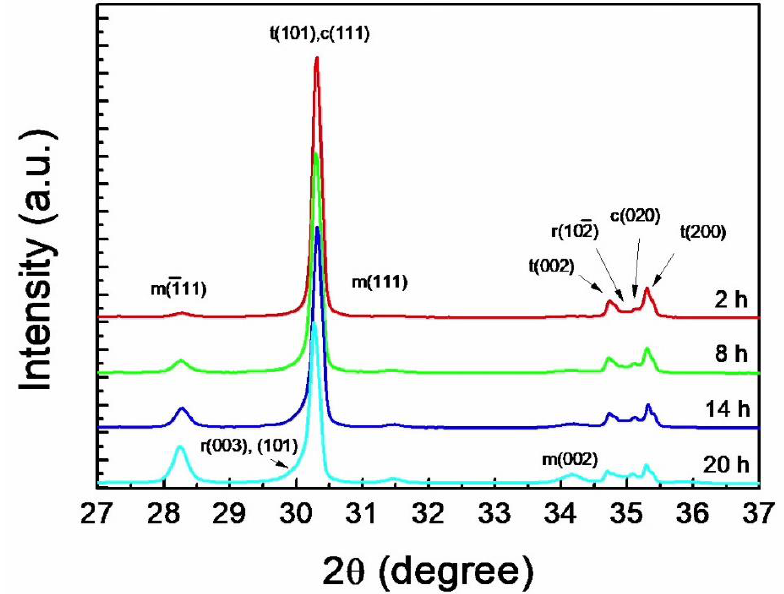
Figure 2. X-ray diffraction patterns of 3Y-TZP sintered for 2–20 h at 1550 ◦ C. The (101) peak of t-ZrO 2 is overlapped with (111) peak of c-ZrO 2 and (003) and (101) peaks of r-ZrO 2 to display an asymmetric broadening. The depth of broadening is proportional to the extent of t → m phase transformation. In Figure 3 the t(101) peak at 30.2 ◦ from the 3Y-TZP sintered for 20 h at 1550 ◦ C was deconvoluted into t-, r-, and c-ZrO 2 phases by the Rietveld refinement. All